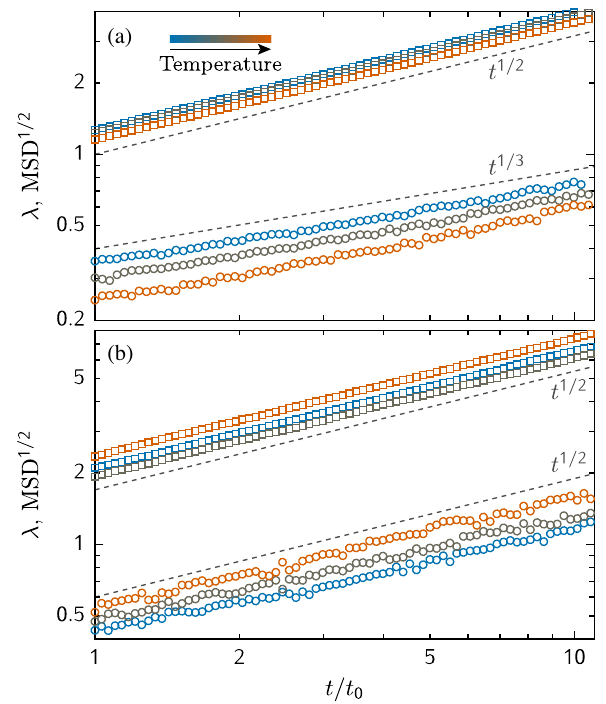
FIG. 2. Brownian yet non-Gaussian regime for the Kob- Andersen binary mixture. Double-log plot of MSD 1 = 2 (squares) and λ (circles) as a function of time for the 3D (a) and 2D (b) Kob- Andersen systems at different temperatures: T ¼ 0 . 45 , 0.5, and 0.6 (3D), and T ¼ 0 . 4 , 0.5, and 0.6 (2D). The λ values for the temperature T ¼ 0 . 4 for the 2D system [blue empty circles in (b)] are rescaled by a factor 0.8 to enhance the readability of the figure. Here, t 0 is the temperature- and system- dependent time at which each system reaches a μ value compatible with 1 within numerical uncertainty, i.e., MSD( t ≥ t 0 ) ∼ t μ ≅ 1 . To determine t 0 , we numerically compute the local exponent μ ð t Þ controlling the time evolution of the MSD( t ), i.e., MSD ð t Þ ∼ t μ ð t Þ (see Sec. VI). Dashed lines in (a) and (b) serve as a